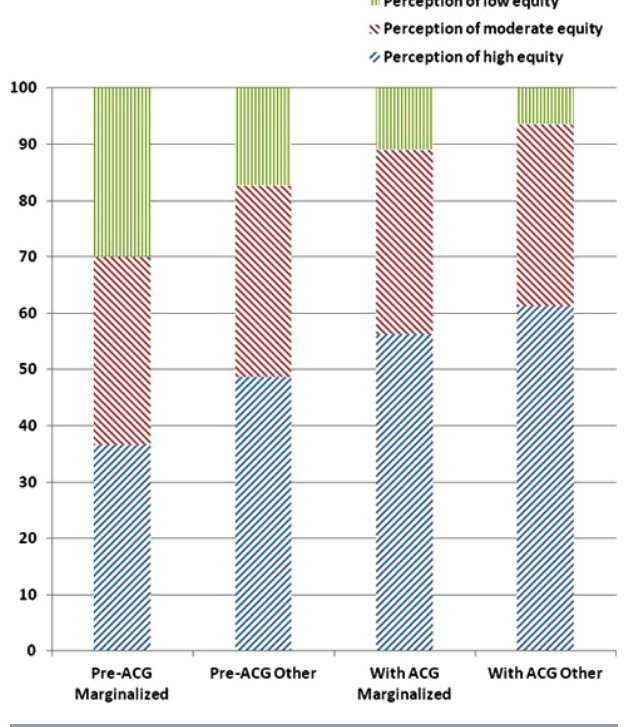
Fig. 4 . Action plans and implementation: comparing pre- and with-adaptive collaborative governance (n = 11). Notes: ACG = adaptive collaborative governance. Pre-ACG = 2000 in the long-term sites (n = 4); 2004 in the short-term sites (n = 7). With-ACG = 2006 in all sites (n = 11). In the pre-ACG period, the most common action plans included some forest protection, plantation, or silvicultural activities and community development such as trail building. In three of the sites with no formal CFUG-agreed action plans in that period, the executive committees did undertake some forest protection or